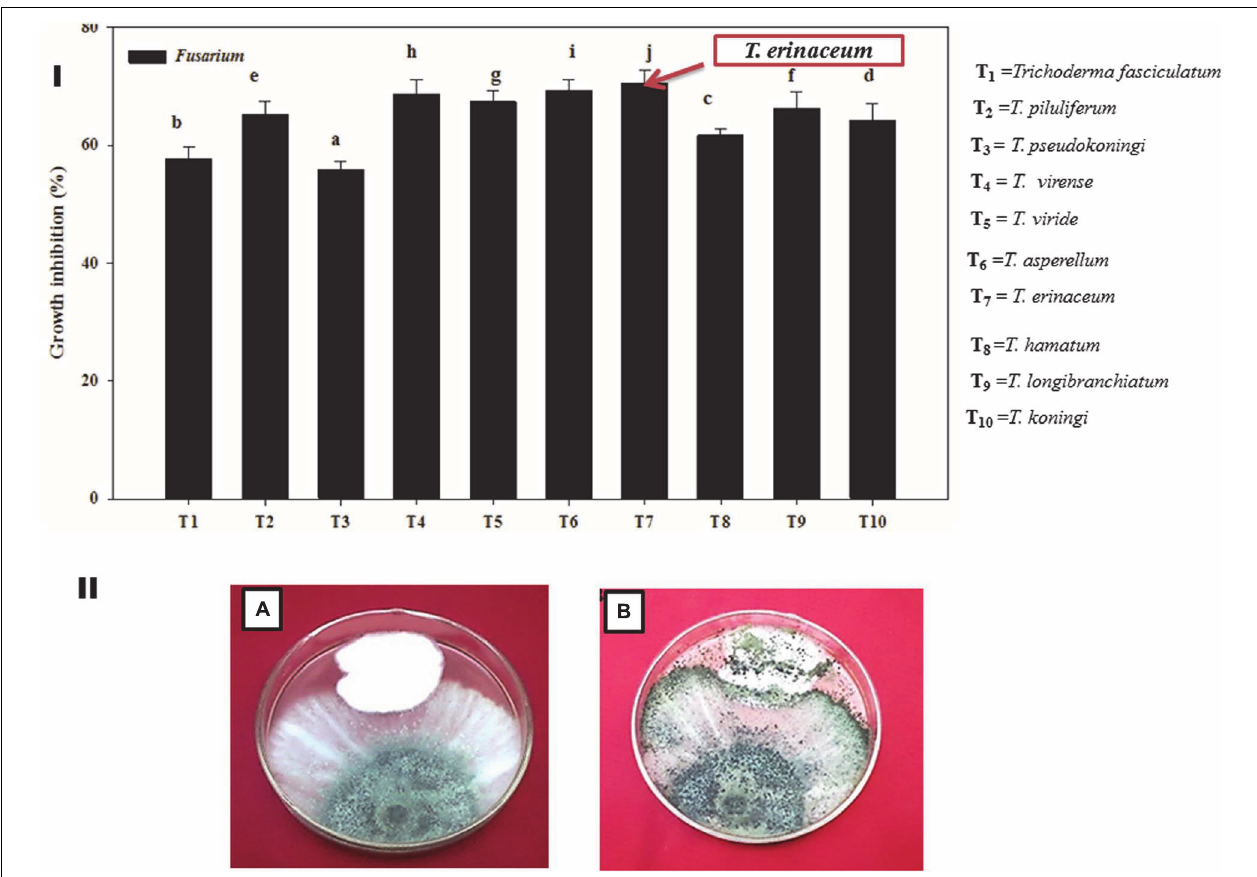
FIGURE 2 | (I) Bar graph showing the efficacy of different species of biocontrol agent Trichoderma spp. in inhibiting the mycelial growth of the Fol pathogen. The figure represents the in vitro mycoparasitic interaction of different isolates of Trichoderma spp. (T 1 –T 10 ) against the Fol pathogen through dual culture assay. The bar graphs represent the percentage growth inhibition of the pathogenic hyphae ( Fol ) by different species of Trichoderma employed in the study. The T. erinaceum (T 7 ) showed the maximum inhibitory action against the Fol pathogen. (II) The Dual culture Assay showing the in vitro mycoparasitic and antagonistic activity of Trichoderma spp. against the pathogen Fusarium oxysporum f. sp. lycopersici . (A) Culture plate showing the mycoparasitic behavior of Trichoderma spp. and the Fol pathogen 5 days post inoculation. (B) The mycoparasitic activity of the Trichoderma showing the growth over the Fol pathogen and the picture was taken 10